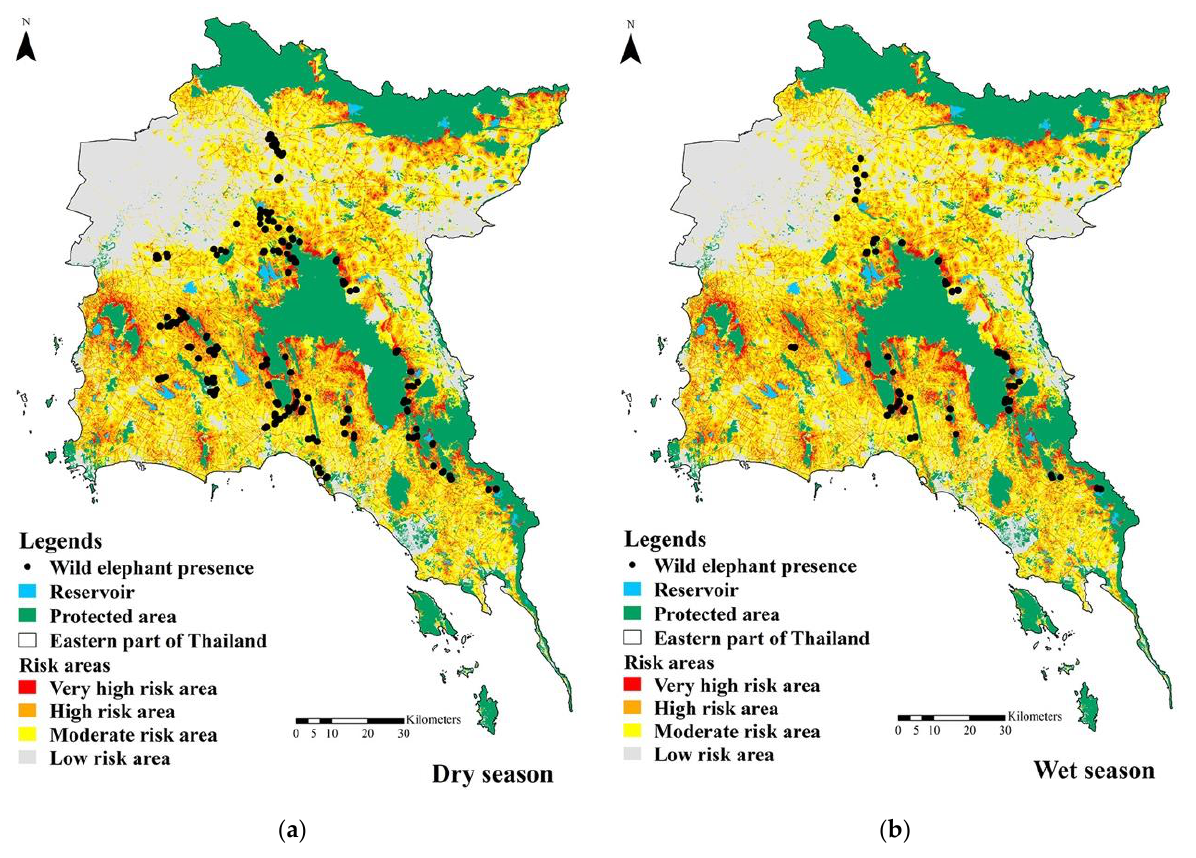
Diversity 2022 , 14 , x FOR PEER REVIEW Figure 3. Human-elephant conflict areas found in 183 households and the risk areas between human-elephant conflict in 2020 in the eastern part of Thailand in ( a ) the dry season and ( b ) the wet season.